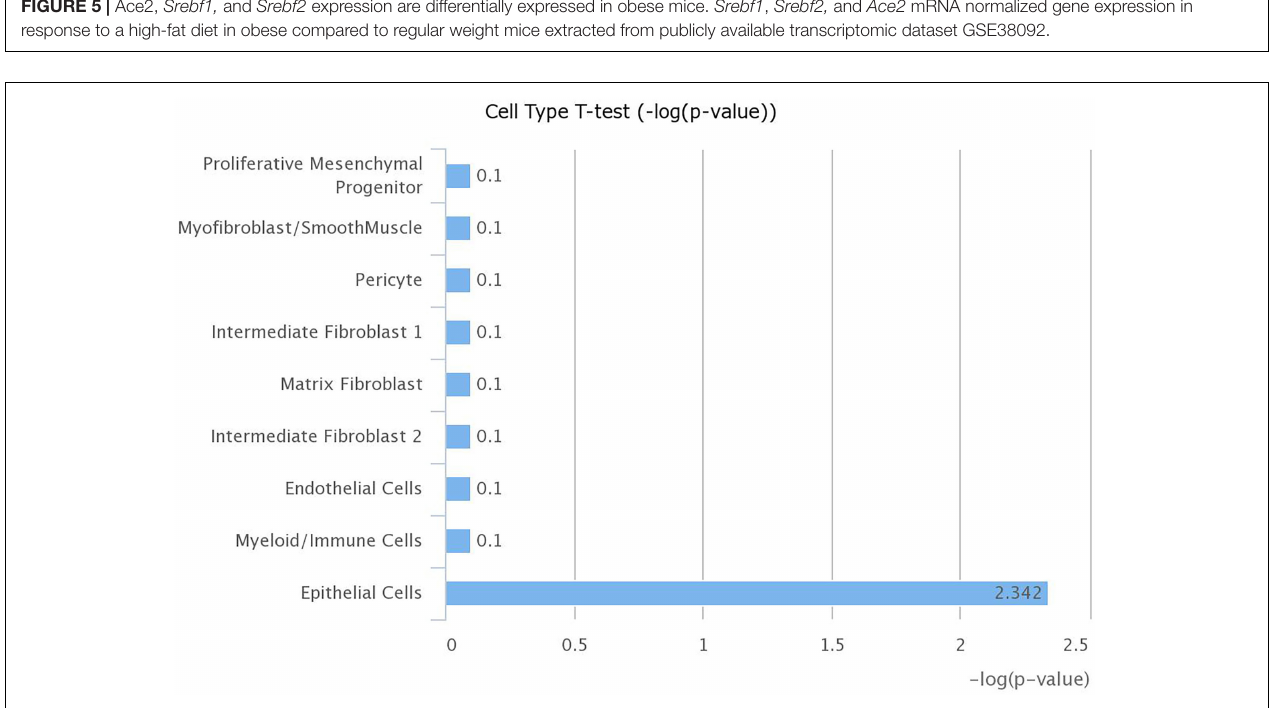
FIGURE 6 | Expression of ACE2 is highest in lung epithelial cells. mRNA expression of ACE2 was examined in different cell types within the lung using LungGENS web-based tool.